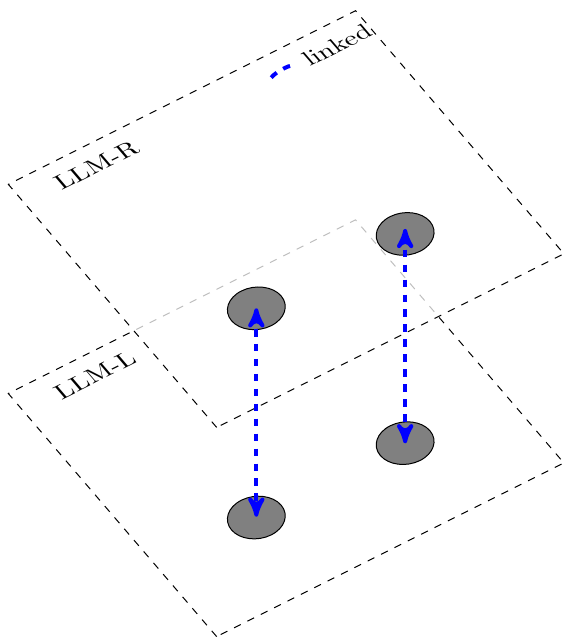
Figure 20 . Schematic representation of the gravity dual for two entangled fermions in coherent states. These allow to localise in phase space the left-right quantum correlations through the linking of their corresponding